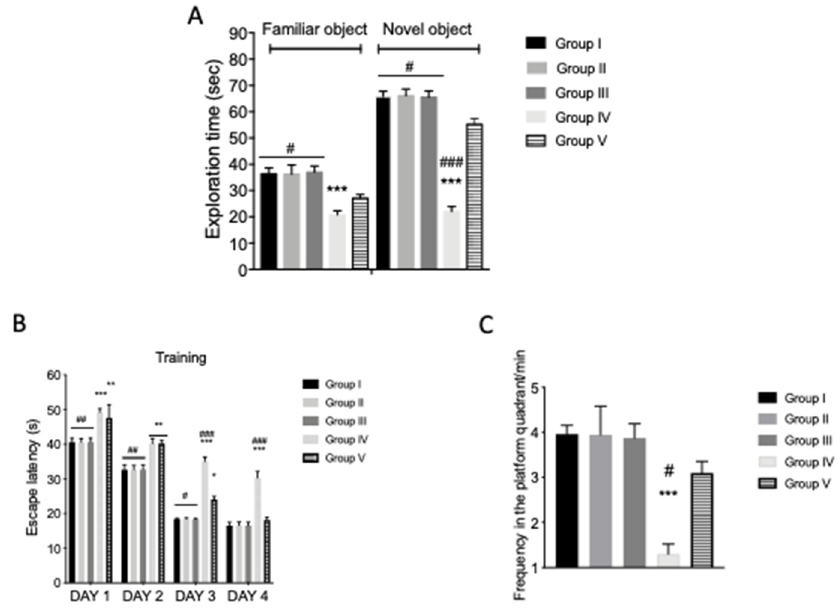
Figure 2. Effect of quercetin on recognition and spatial memory in AFB1 mice. Group I (control); Group II (veh + control); Group III (quercetin-only); Group IV (AFB1); Group V (afb1 + quercetin). Novel object recognition (NOR) and Morris water maze (MWM) tests were evaluated. ( A ) Exploration time in seconds; ( B ) escape latency; ( C ) frequency in the platform quadrant/min. Quercetin treatment was able to increase the exploration time for novel object recognition compared to the AFB1 group ( A ); to increase the time to finding the platform ( B ); as well as the frequency time around and within the target quadrant of the platform ( C ), compared to controls. Values are mean ± SEM of 8 mice/group. * p < 0.05 vs. veh + control group; # p < 0.05 vs. AFB1 + quercetin.